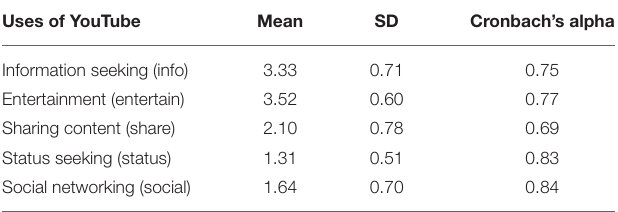
TABLE 2 | Descriptive statistics for uses and gratifications